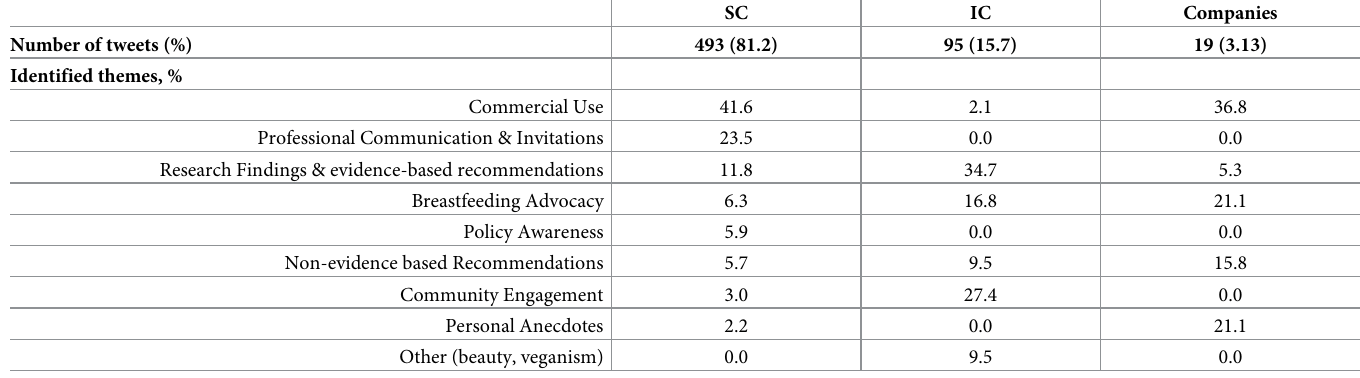
Table 3. Content analysis of tweets by influencer category ( n = 711